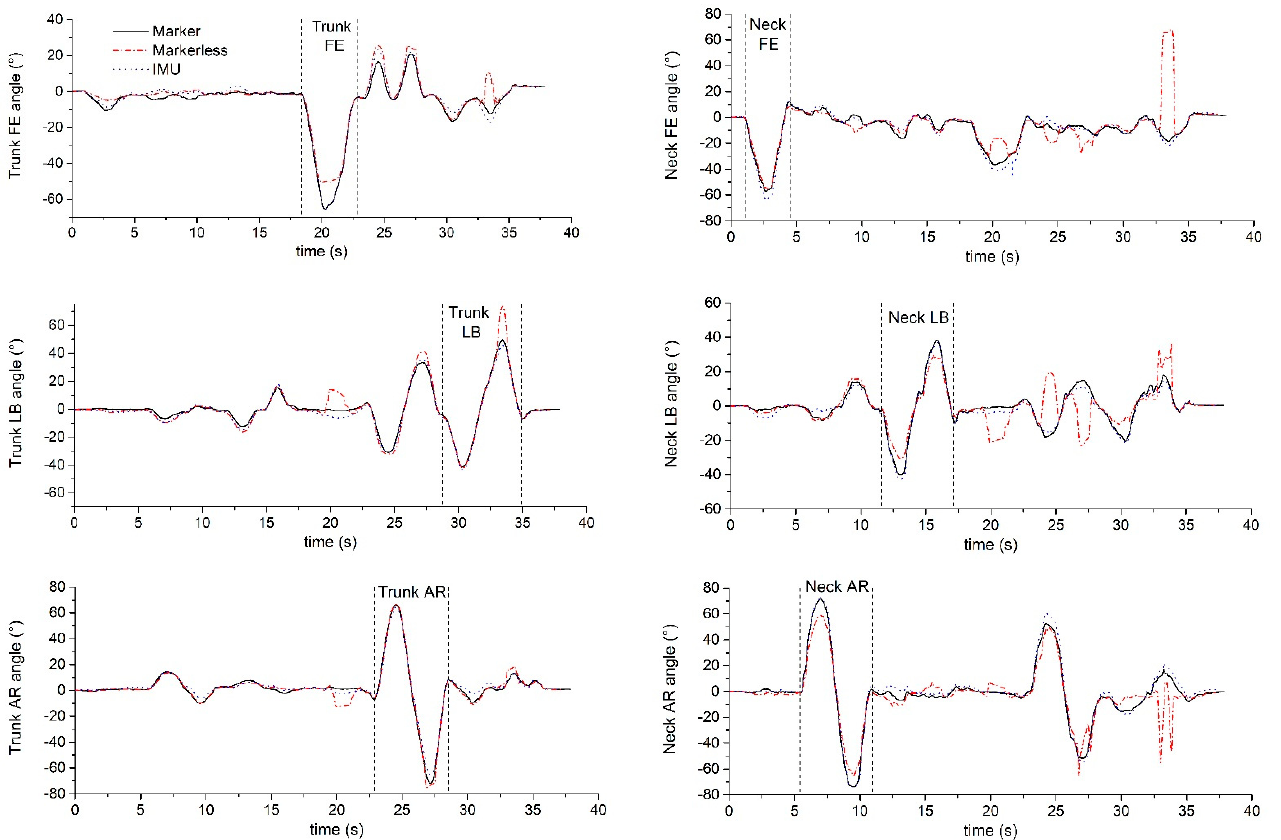
Figure 5. Exemplar SP − movements, the movement sequence is Neck FE, AR, LB and Trunk FE, AR, LB (between to dash line was the simple plane movement).